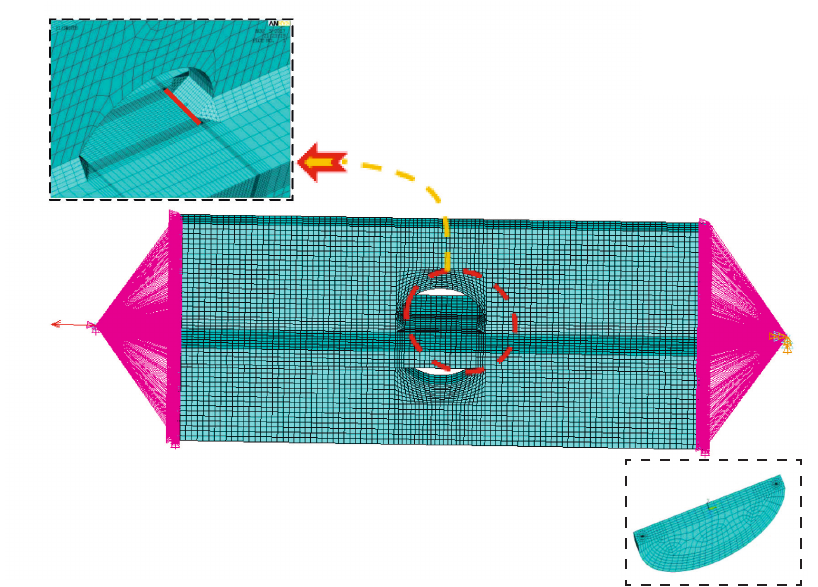
Figure 5. Three-dimensional Finite Element Model of fracture mechanics by